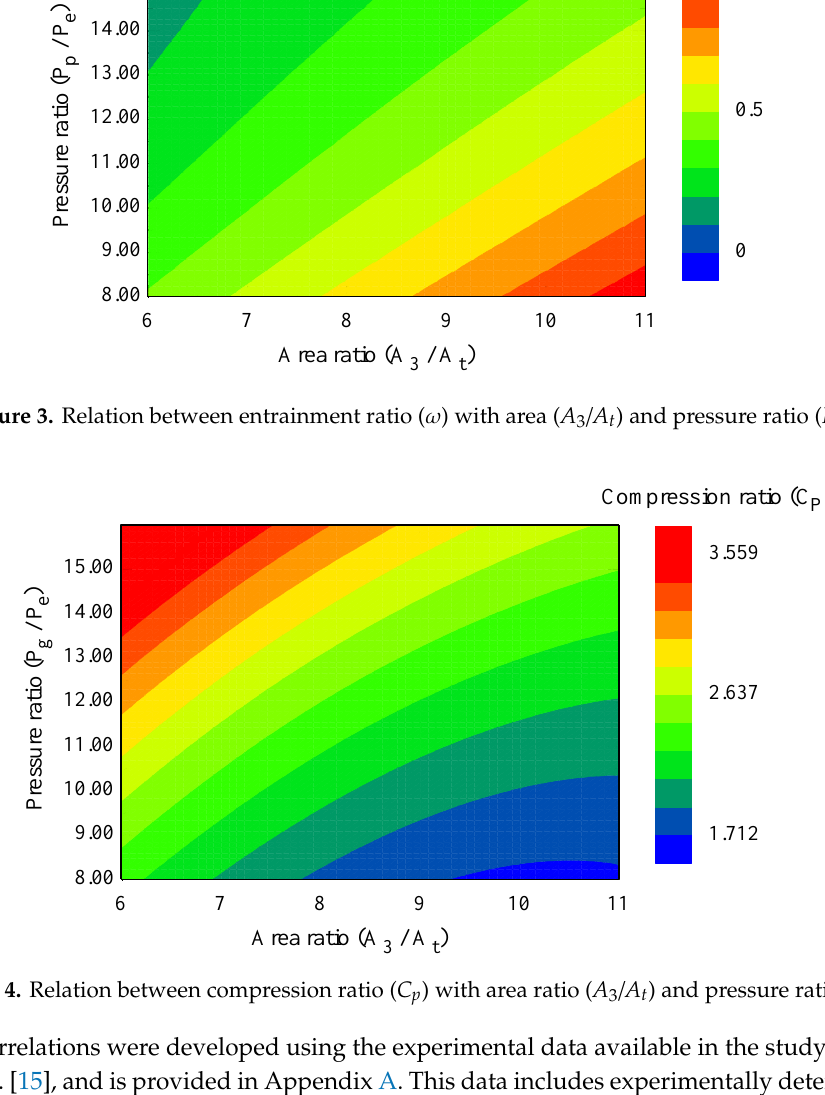
Figure 4. Relation between compression ratio ( C p ) with area ratio ( A 3 / A t ) and pressure ratio ( P g / P e ).